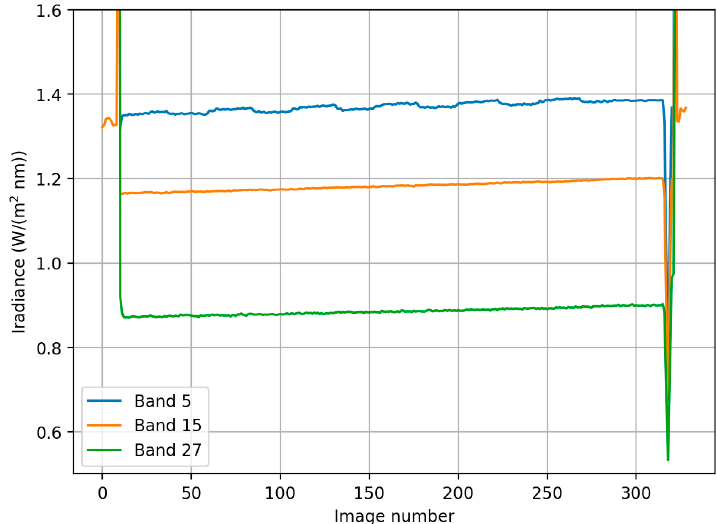
Figure 17. Corrected OO cor irradiance during the flight for green (band 5, (cid:2019) (cid:2868) = 537.2 nm), red (band 15, (cid:2019) (cid:2868) = 628.6 nm) and NIR (band 27, (cid:2019) (cid:2868) = 748.8 nm) range bands.